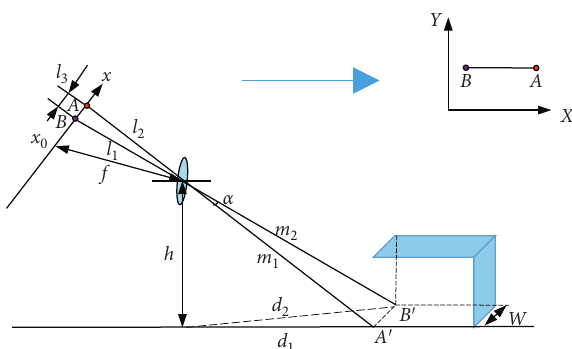
Figure 7: Schematic diagram of static